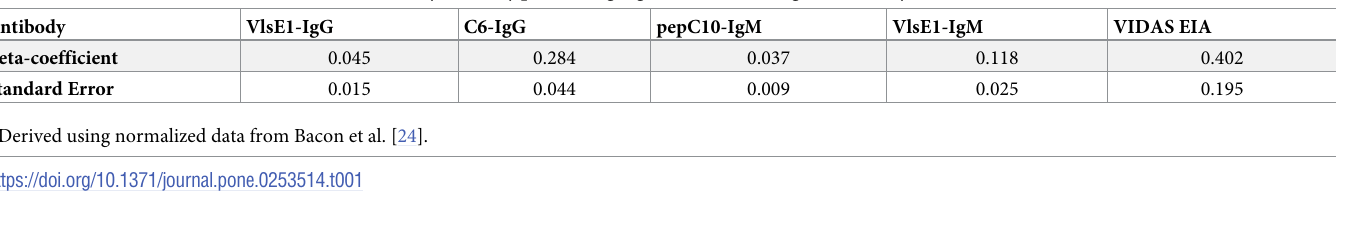
Table 1. Beta-coefficients and standard errors of study antibody panel using logistic-likelihood regression analysis a